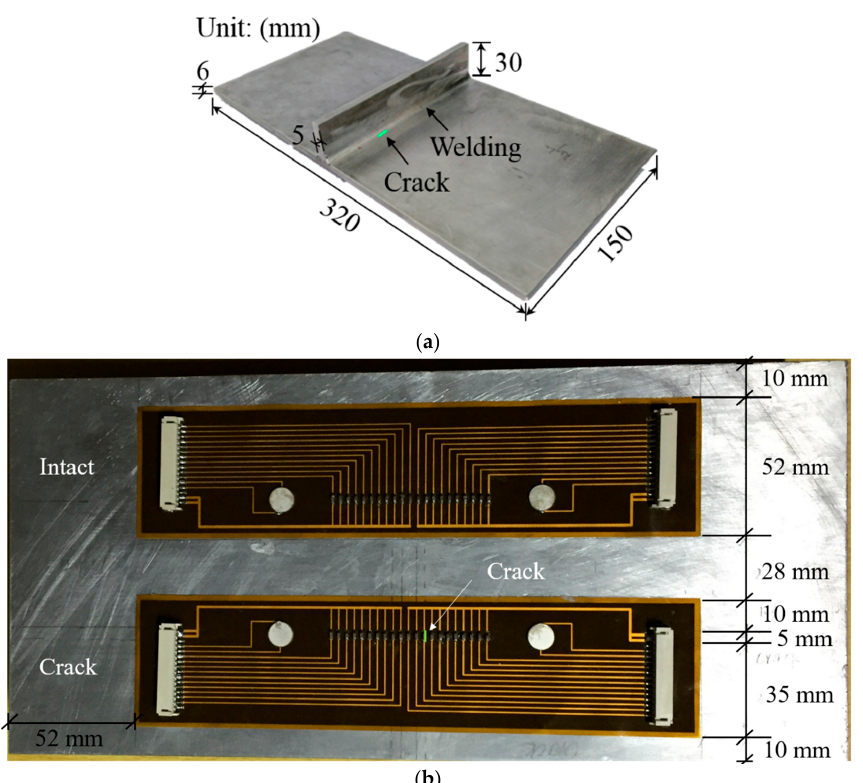
Figure 12. Target structure with the stripe-PZT sensors: ( a ) a vertically stiffened aluminum specimen with a crack and ( b ) installation of the stripe-PZT sensors on the opposite surface of the stiffener and the crack.